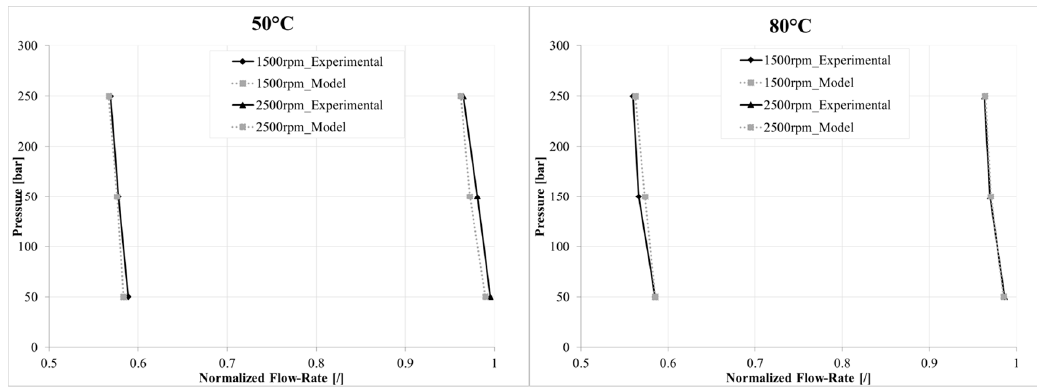
Figure 12. Delta torque between experimental data and simulation data at 1000, 1500 and 2500 rpm. Energies 2017 , 10 , 1113